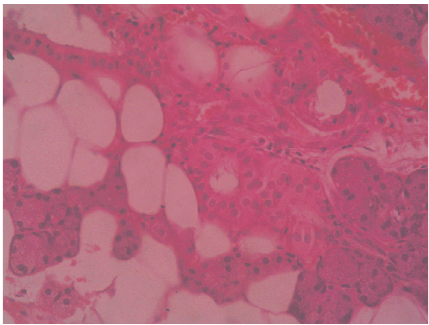
Figure 4: Wall of the cystic cavity is composed of sebaceous glands, adipose tissue, salivary gland tissue, and hyaline